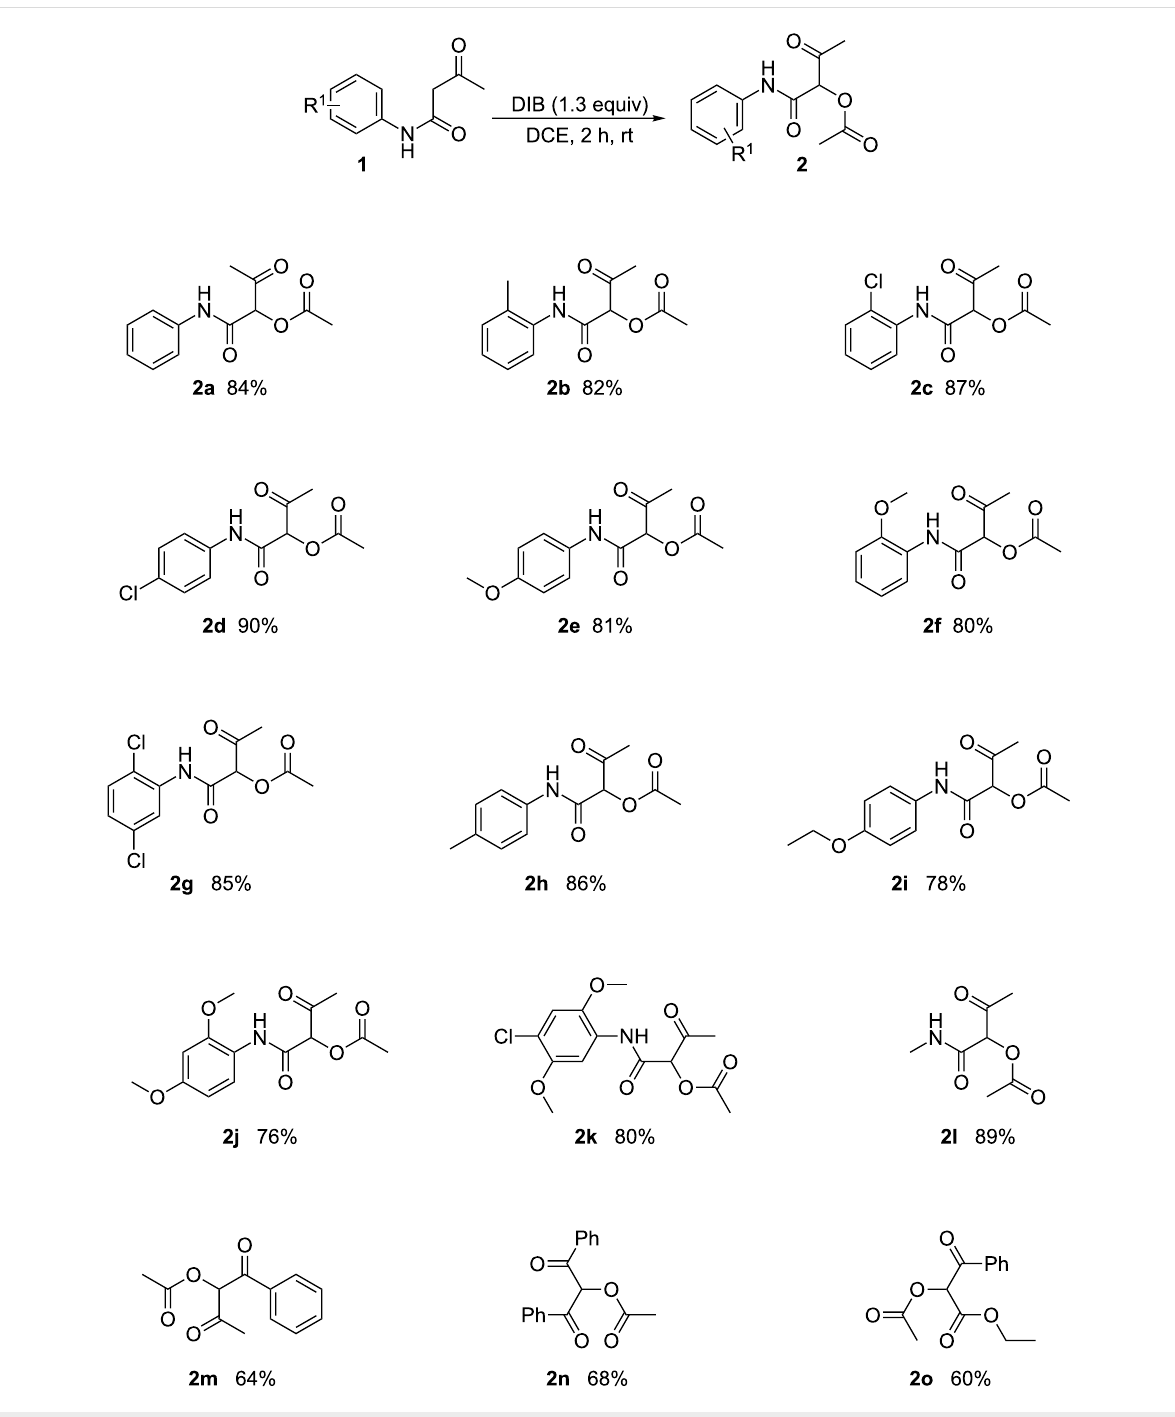
Scheme 2: The synthesis of 1-carbamoyl-2-oxopropyl acetates. Conditions: 1 (1.0 mmol), DCE (2 mL), DIB (1.3 equiv); %: Isolated yield.